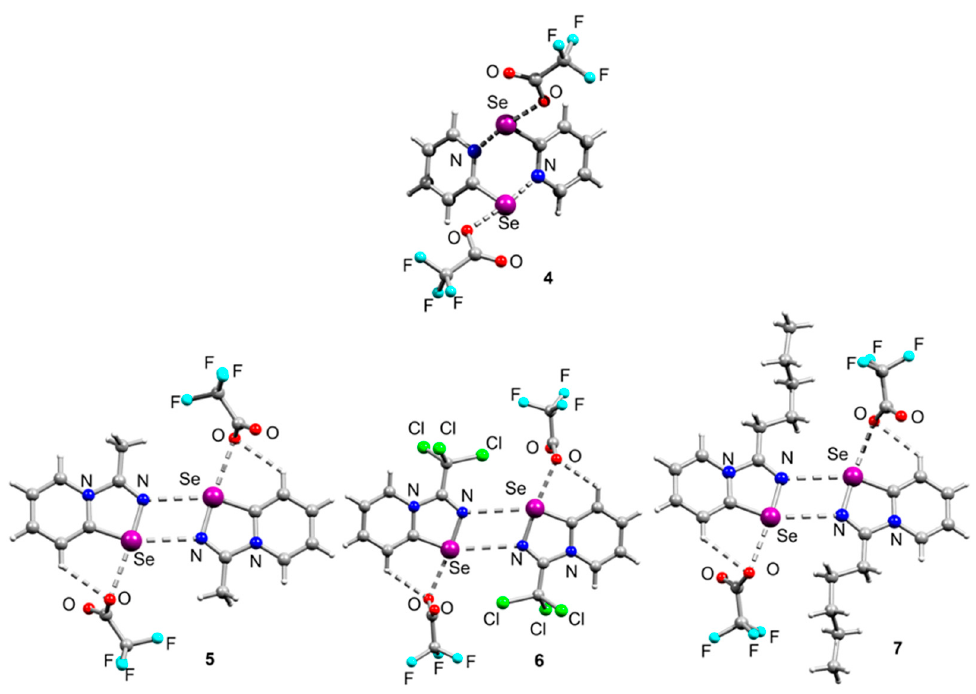
Figure 1. Ball-and-stick representations of the crystal structures of 4 – 7 demonstrating supramolecular dimerization via Se · · · N ChB. Grey and light-grey spheres represent carbon and hydrogen, re- spectively.